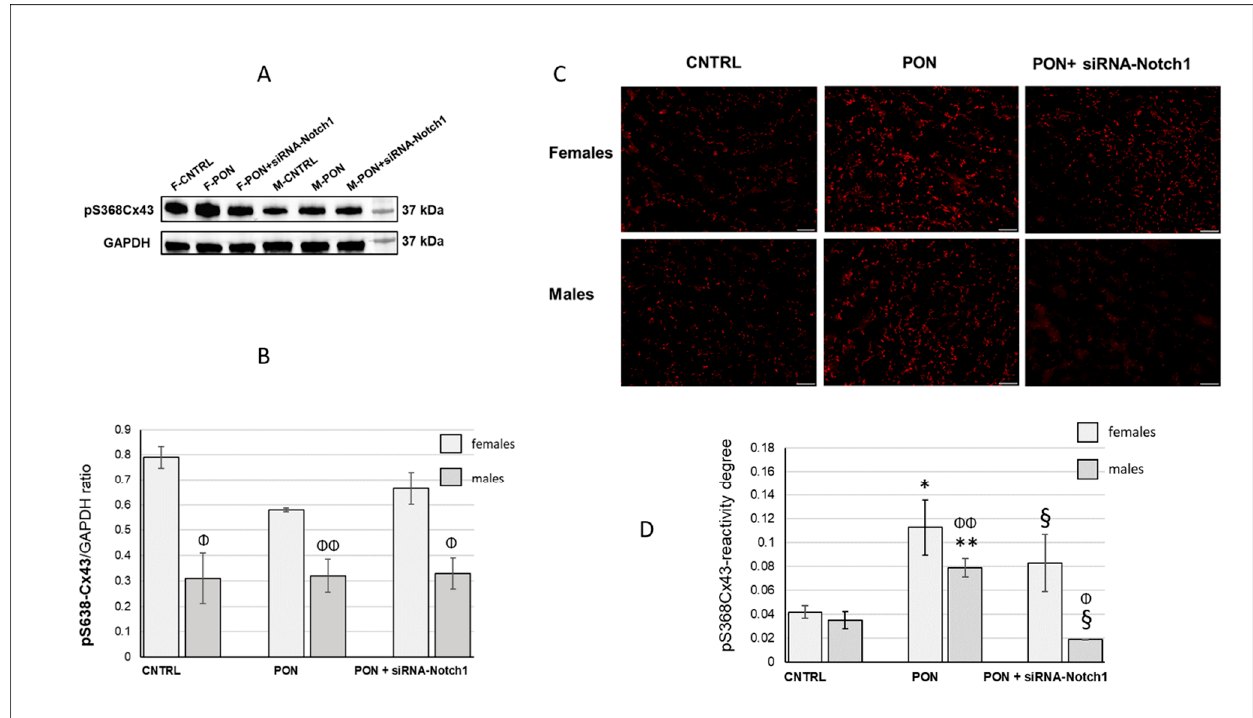
Figure 5. pS368-Cx43 protein expression. ( A ) Representative of a Western blot analysis of one group of the three analysed groups. ( B ) Histogram obtained by Western blot analysis, representing the total cardiac pS368-Cx43 protein expression of heart mice samples. ( C ) Immunofluorescence staining: representative images of cardiomyocyte pS368-Cx43 immunoreaction (red). Magnification: 200×. Bars: 50 µm. ( D ) Image analysis of cardiomyocyte pS368Cx43-immunofluorescence. Data are expressed as mean ± standard deviation, n = 4. * p < 0.001 vs. CNTRL; ** p ≤ 0.001 vs. CNTRL and PON + siRNA-Notch1; §: p ≤ 0.001 vs. CNTRL; Φ : p < 0.01 vs. females; Φ Φ : p < 0.05 vs. females.